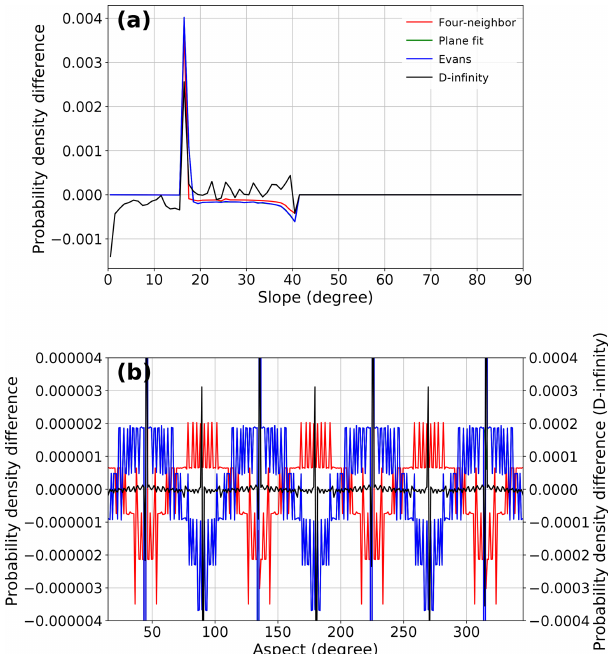
Figure 1. (a) Slope and (b) aspect distribution differences from an- alytical solutions of slope and aspect on a Gaussian hill, on 1 ◦ bins, starting from [0.5, 1.5). None of the methods perfectly match the analytical solution, with slightly different offset magnitudes. Note that the D-infinity method (black line) produces aspect frequency distribution errors 2 orders of magnitude larger than those errors produced by the other methods. It is important to note, however, that the aspect offsets are small – on the order of 1–5 pixels per bin for the methods excluding